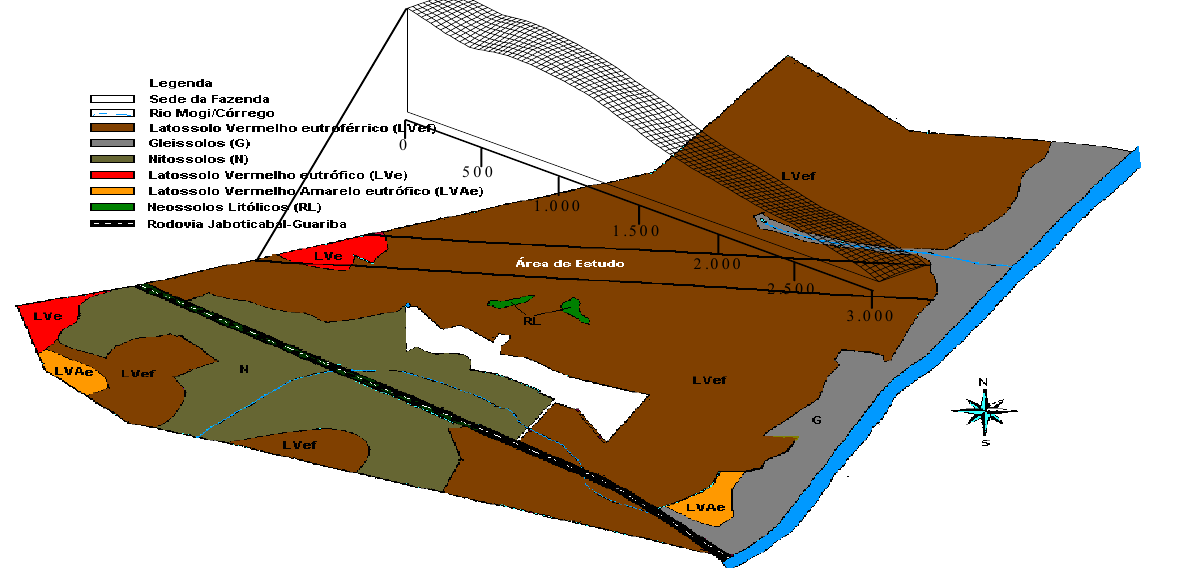
Figura 1. Mapa de solos da Fazenda Santa Isabel, com indicação da localização da área de estudo e sua forma do relevo (adaptado de Prado